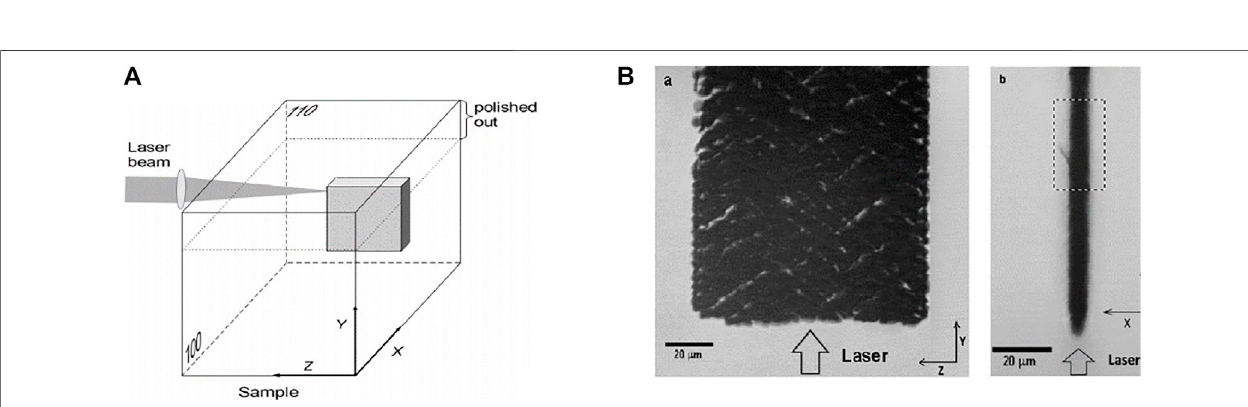
Frontiers in Physics |